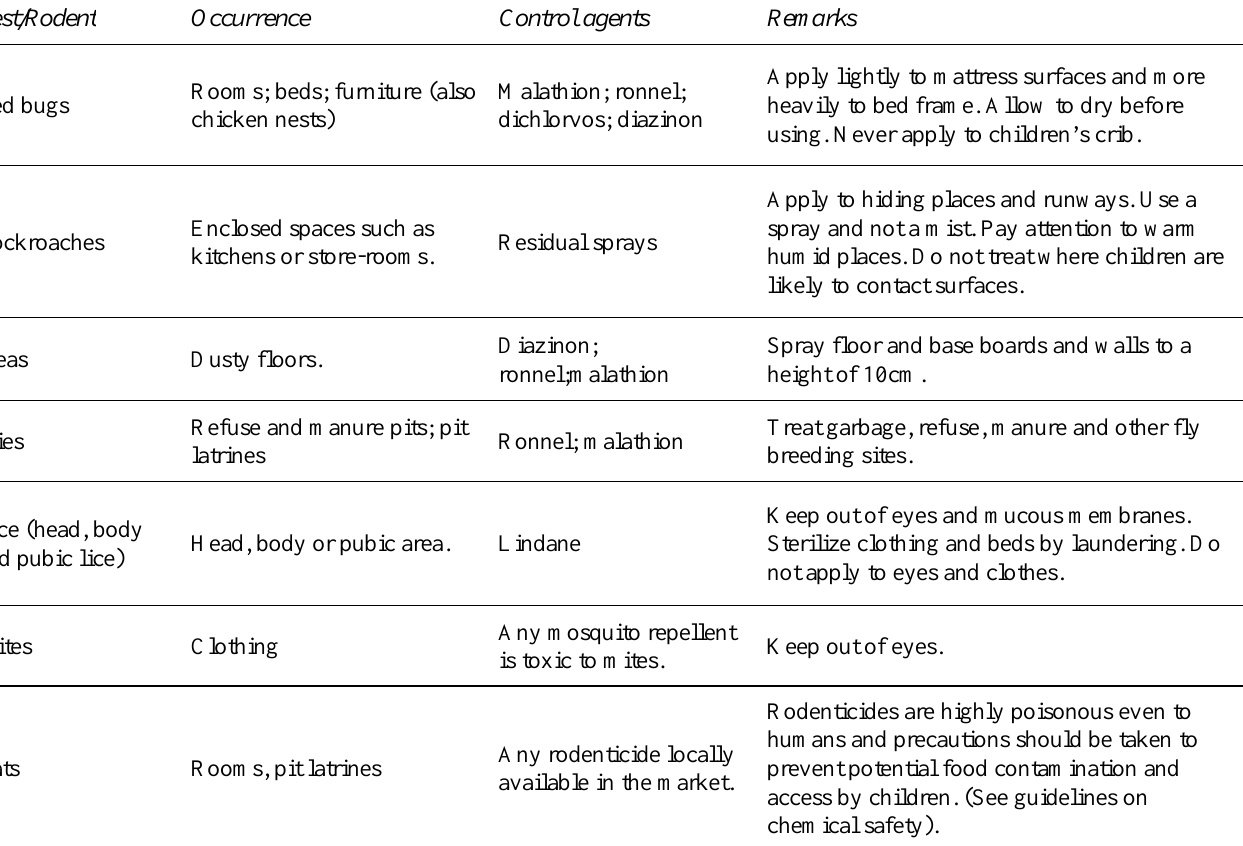
Table 6: Common Pests & Rodents and their Control Measures